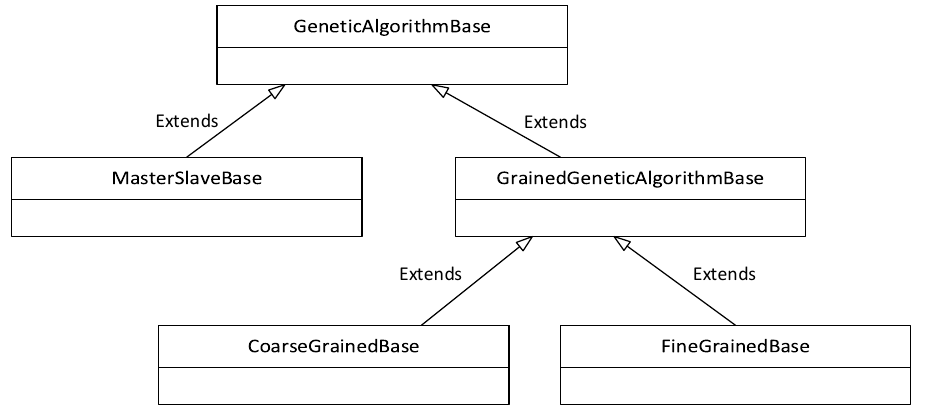
Figure 2. UML diagram of the structure of GA classes.